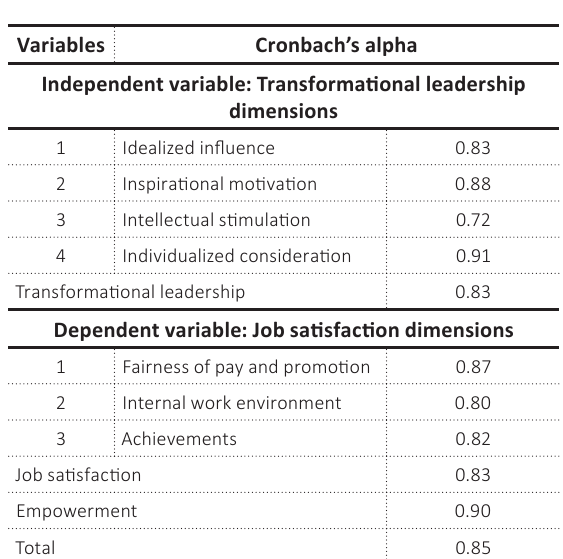
Table 1. Cronbach’s alpha values